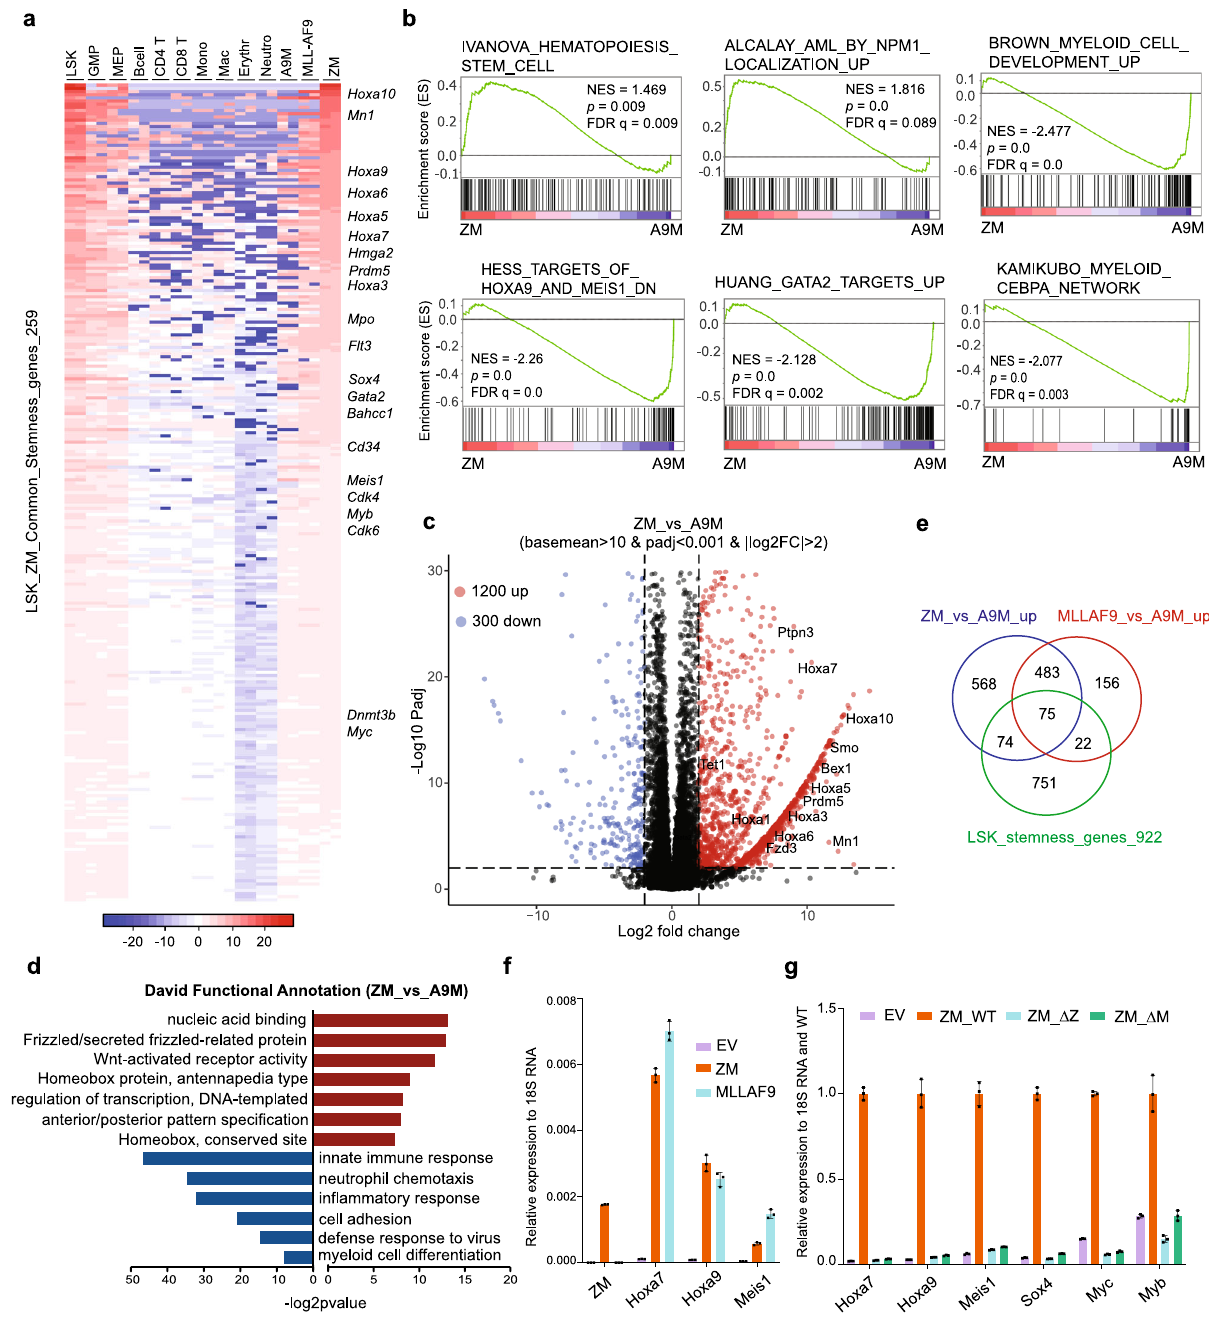
Fig. 2 ZM enforces aberrant activation of a pro-leukemic stemness gene-expression program including Hoxa, Meis1, Sox4, Myc and Myb. a Heatmap of 259 genes showing higher expression in both normal LSK (Lin-/Sca1 + /c-Kit + ) and ZM-immortalized murine AML cells, relative to mature blood cell types. Expression values represent mean-centered log2(TPM). Genes are sorted in a descending order based on their expression values in ZM + AML cells. A9M and MLL-AF9 represent the murine AML lines established by the coexpressed Hoxa9 plus Meis1a (A9M) and MLL-AF9, respectively. b GSEA shows enrichment of the HSC-related and mutant-NPM1-upregulated genes in ZM + relative to A9M + cells, as well as enrichment of genes upregulated upon myeloid differentiation or the indicated TF-related transcripts in A9M + relative to ZM + cells. The p value ( n = 15,282 genes per group) was calculated by an empirical phenotype-based permutation test. The FDR is adjusted for gene set size and multiple hypotheses testing while the p value is not. c Volcano plot displays differentially expressed genes (DEGs) identi fi ed in ZM + versus A9M + AML cells. The up- and down-regulated DEGs, de fi ned with the indicated cutoff, are represented by red and blue dots, respectively, with example stemness-related genes highlighted. d DAVID functional annotation of DEGs identi fi ed in ZM + versus A9M + AML cells, with the enriched terms for upregulated ( n = 1200 genes) and downregulated ( n = 300 genes) DEGs indicated by red bars and blue bars, respectively. The p value was calculated by Fisher ’ s Exact test. e Venn diagram showing overlaps among ZM-upregulated genes (versus A9M), MLL-AF9-upregulated genes (relative to A9M), and LSK stemness genes. f RT-PCR of Hoxa7, Hoxa9 and Meis1 in ZM- and MLL-AF9-transformed AML cells. qPCR signals from three independent experiments were normalized to those of 18S RNA and presented as mean ± SD. g RT-PCR of AML-related proto-oncogenes in murine HSPCs post-transduction of EV or the indicated ZM. qPCR signals from three independent experiments were normalized to those of 18S RNA and then WT ZM and presented as mean ± SD. NATURE COMMUNICATIONS| (2021) 12:1045 |https://doi.org/10.1038/s41467-021-21357-3|www.nature.com/naturecommunications